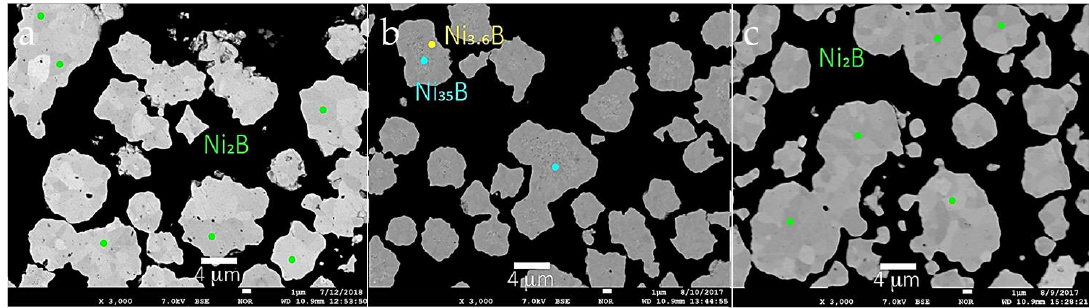
Figure 7. Backscattered electron images of aggregates from ( a ) Run 3; ( b ) Run 4; ( c ) Run 5. Colored circles denote locations of spot analyses using the EPMA coded to compositions listed in the figure. Table 3. Average compositions of selected regions in aggregates from Run 3, Run 4, and Run 5. Compound